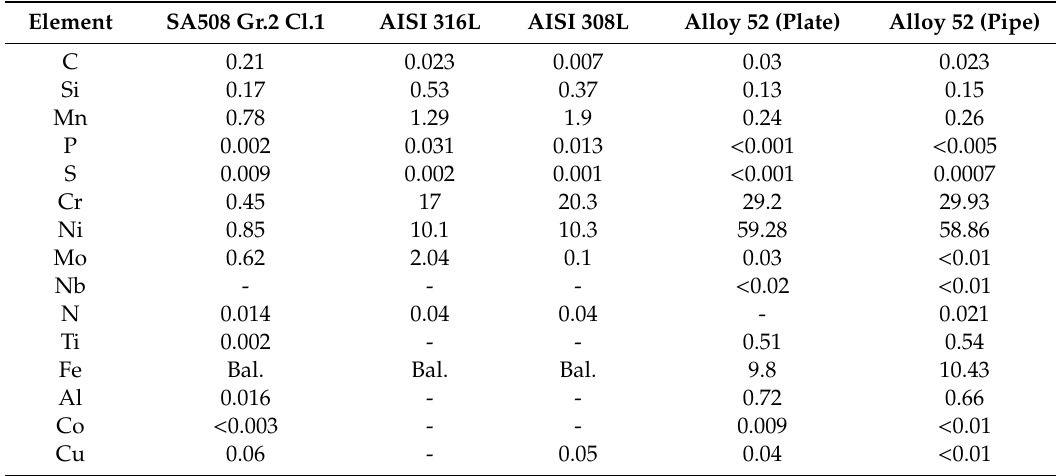
Table 1. Chemicalcompositions(inwt.